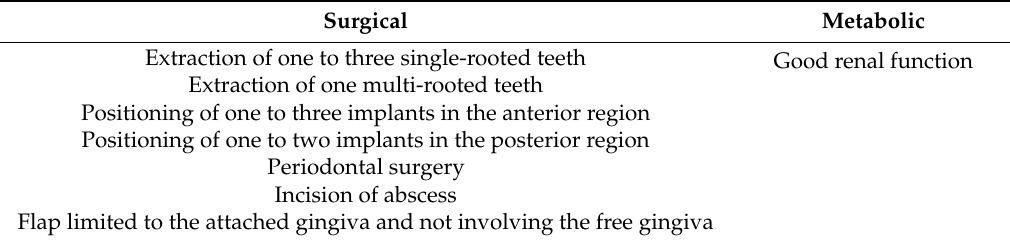
Table 5. Parameters for indication of continuation of